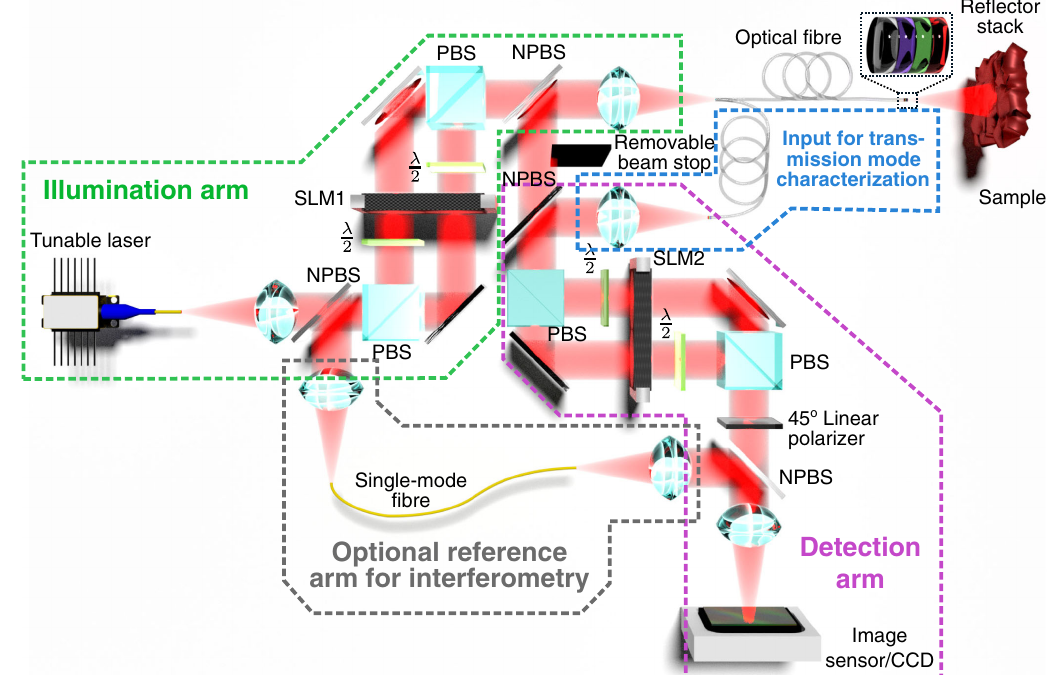
FIG. 9. Conceptual experimental setup for fiber TM characterization in the reflection mode configuration using a distal reflector stack. SLM: spatial light modulator; PBS: polarizing beam splitter; NPBS: nonpolarizing beam splitter; λ = 2 : half-wave